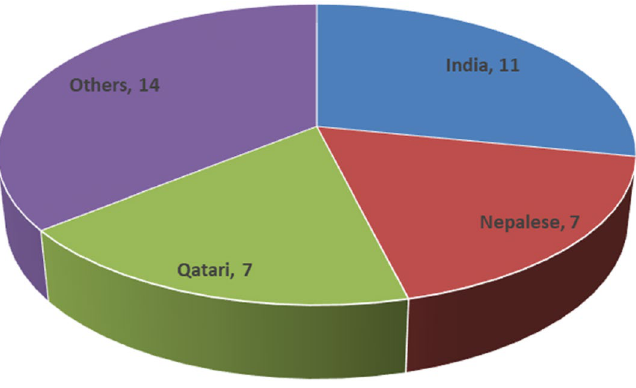
Figure 1. Nationality distribution among the